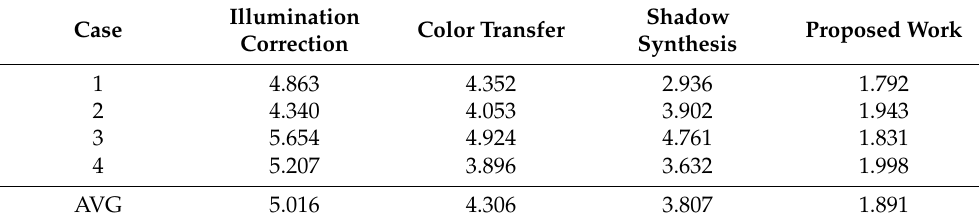
Table 3. Objective evaluation results of color difference (CD).